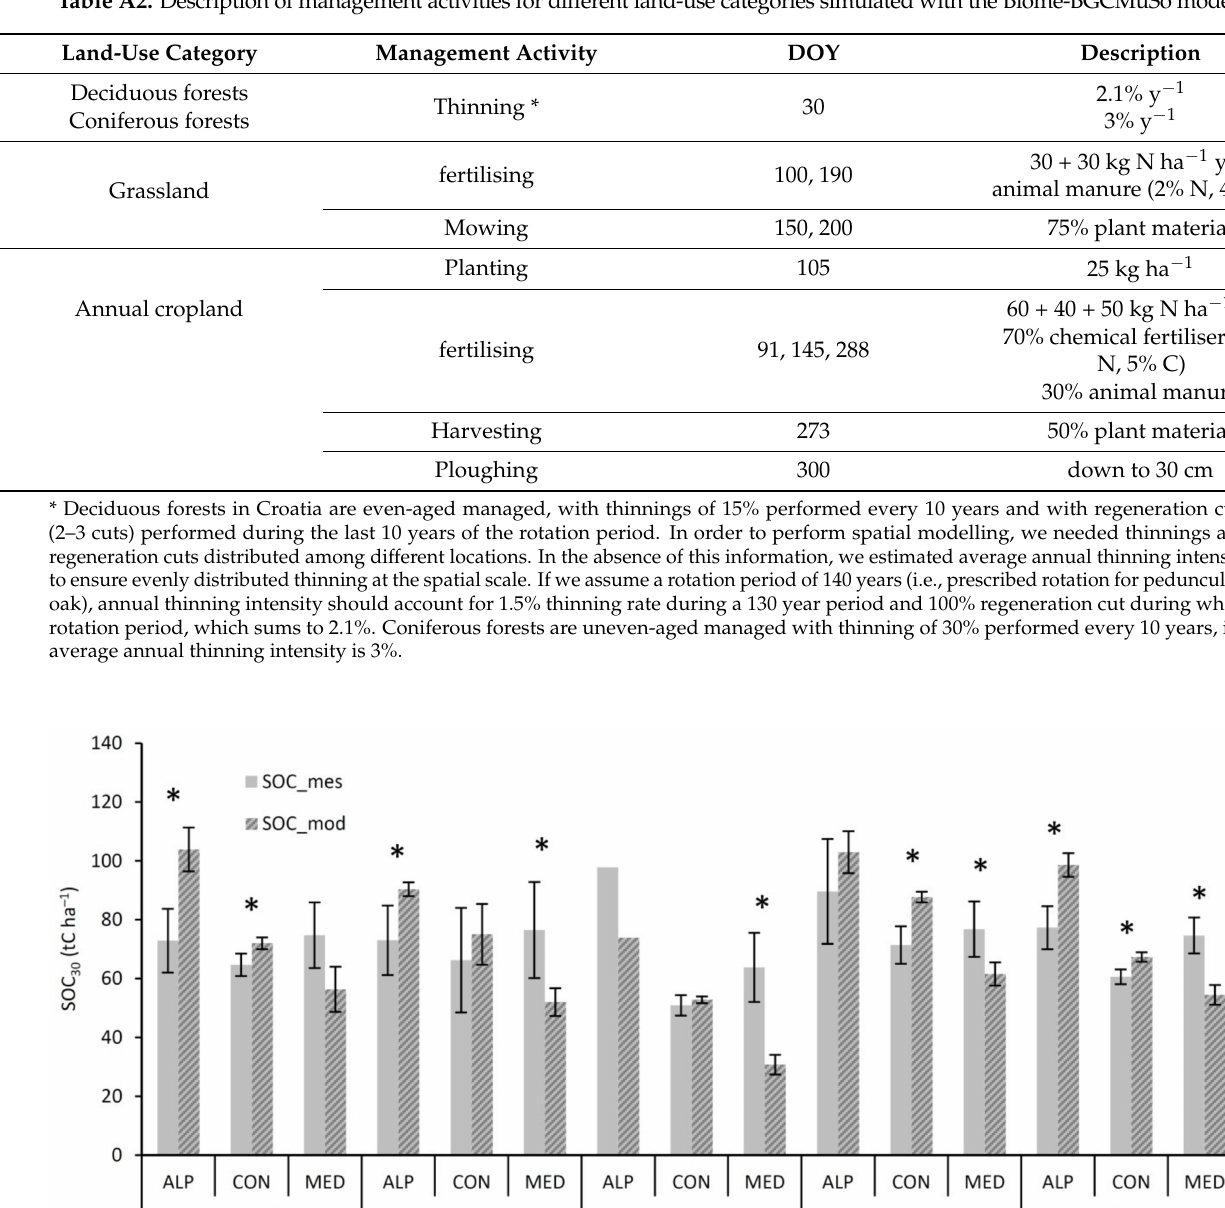
Table A2. Description of management activities for different land-use categories simulated with the Biome-BGCMuSo model.